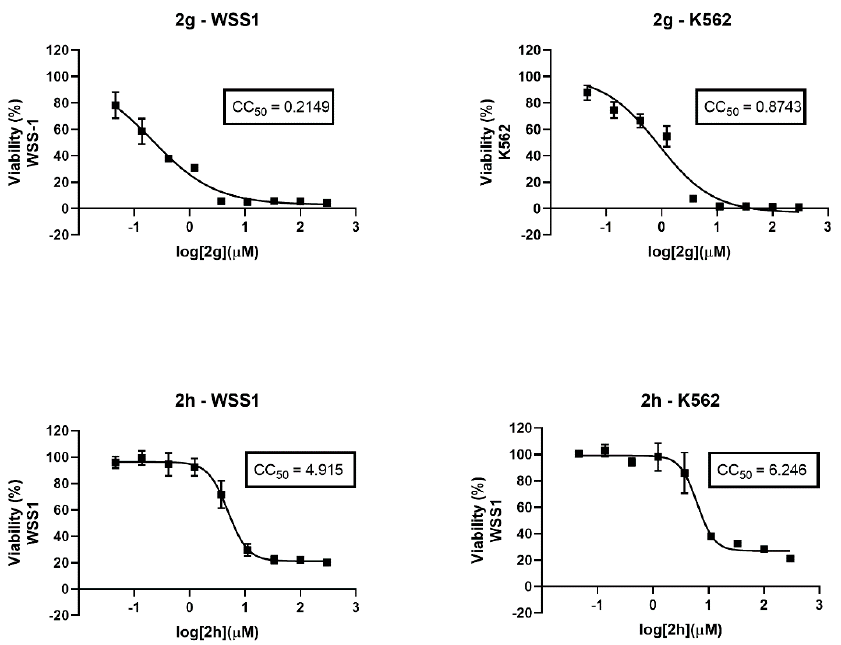
Figure 5. Concentration-response curves of compounds 2g – h in K562 and WSS-1 cells, where the minimum reached viability percentage for K562 and WSS-1 cells was approximately 20%, indicating a possible solubility problem.